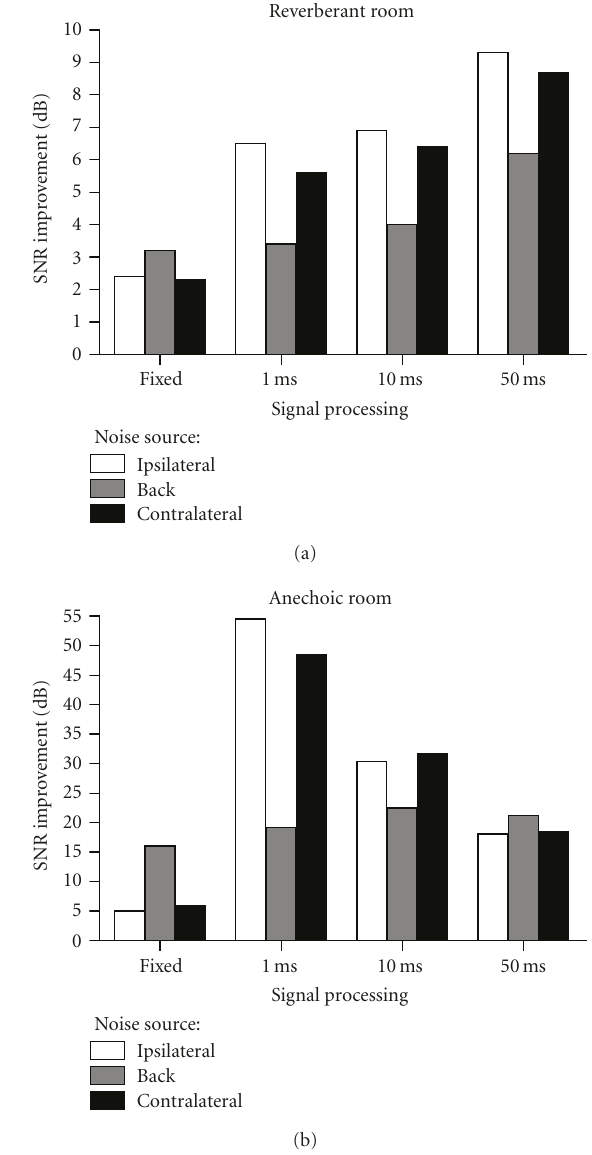
Figure 4: SNR improvements of the two-microphone noise reduc- tion system. Top panel: results from simulations in a reverberant room with a reverberation time of 0.4 seconds. Bottom panel: simulations in an anechoic room. Noise reductions are shown as a function of the direction of incidence of the noise and the signal processing used. Label “Fixed”: simple fixed directional system, corresponding to signal (b) in Figure 1. Labels “1 millisecond”, “10 milliseconds”, and “50 milliseconds”: output of an adaptive system corresponding to signal (e) in Figure 1, using the given length for the adaptive